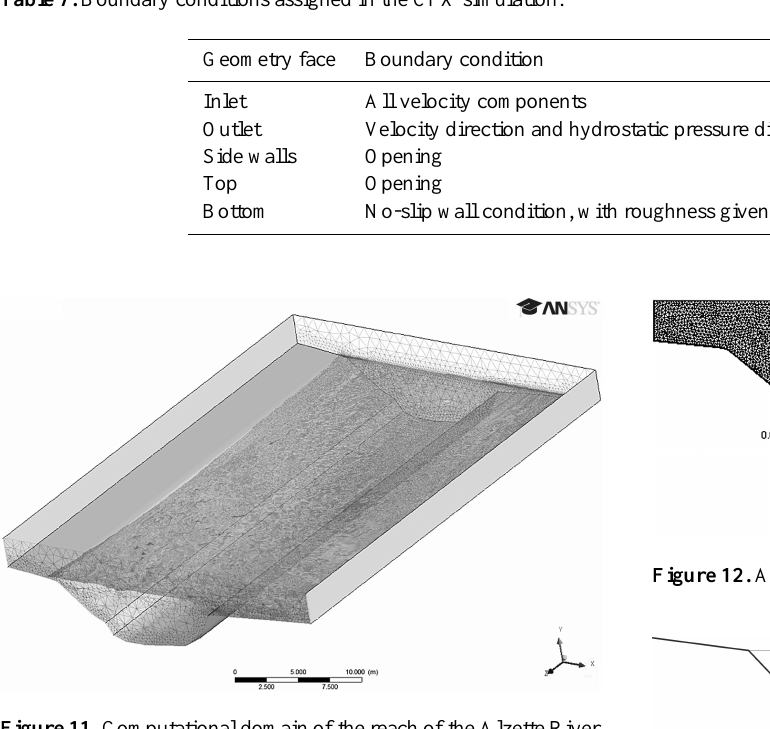
Figure 11. Computational domain of the reach of the Alzette River.